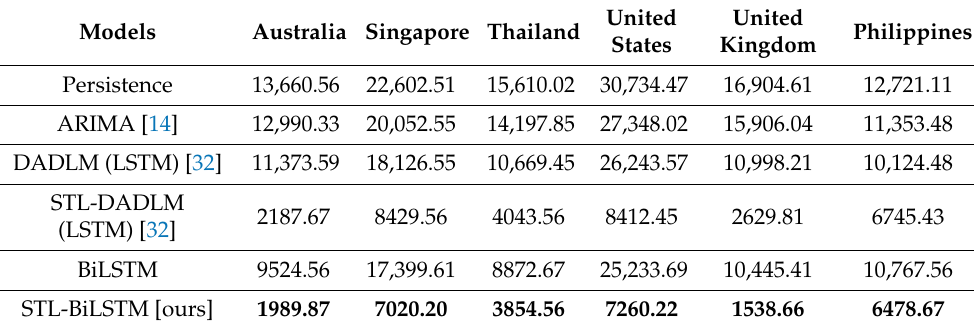
Figure 3. Sensitivity analysis of different parameters in case of Singapore arrivals in Hong Kong. Table 3. RMSE comparison for selected forecasting methods for six source countries.